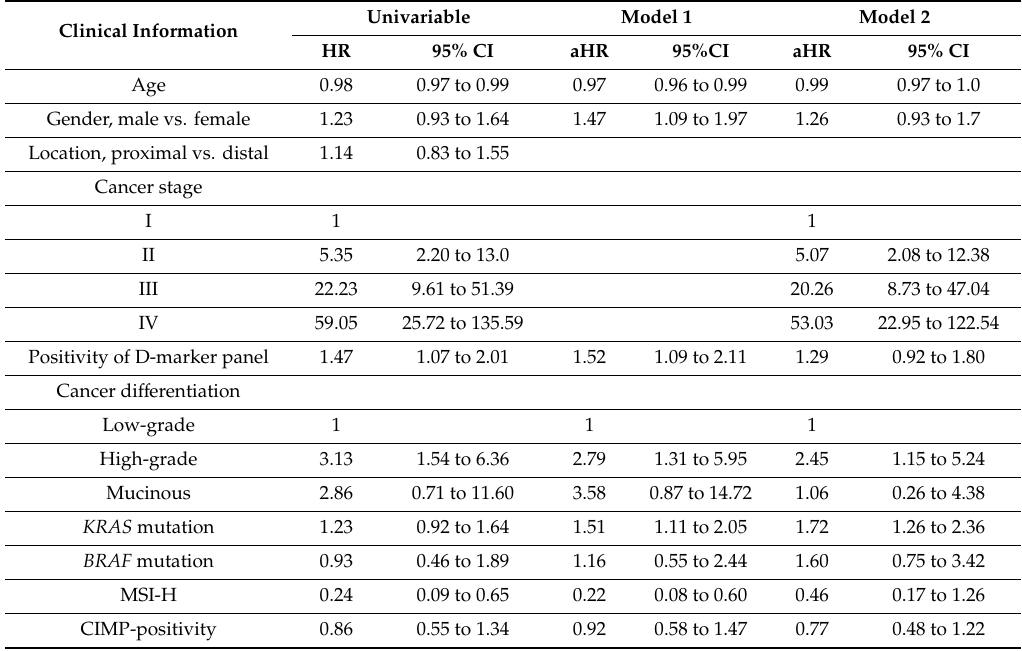
Figure 4. Comparison of survival outcome between proximal CRC with and without a positive D- marker panel when using oxaliplatin as first-line chemotherapy. Proximal CRC with a positive D- marker panel had a worse response to chemotherapy with oxaliplatin as a first-line agent. Compared to those without D-marker, proximal CRC with a positive D-marker panel had an unfavorable overall survival ( A ) and progression-free survival ( B ). The p -values were 0.045 and 0.0065, respectively.